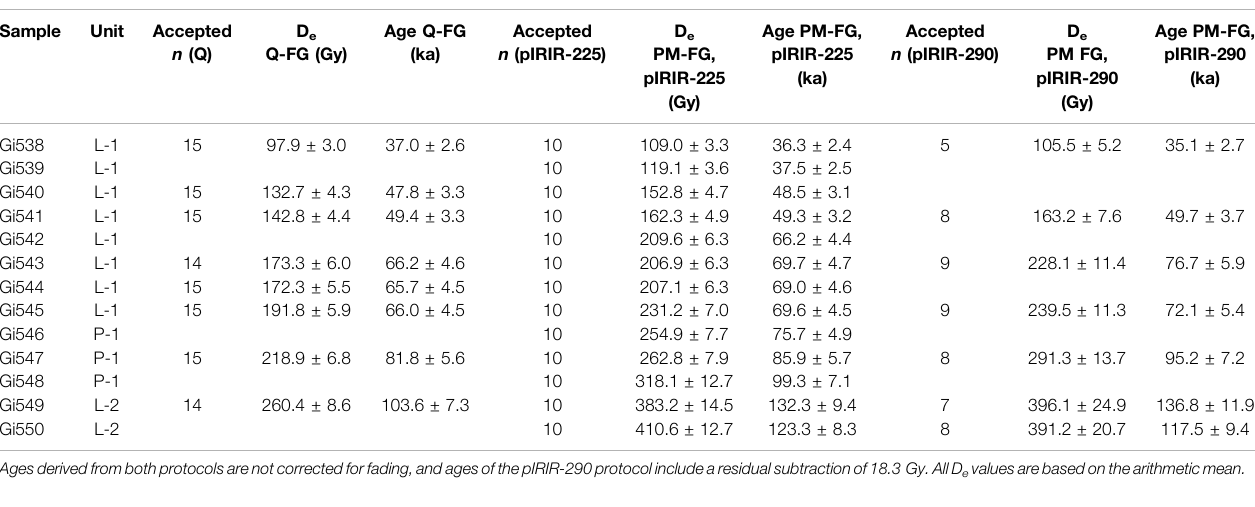
TABLE 6 | Luminescence ages for the quartz (Q-FG) and polymineral fi ne (PM-FG) grain fraction. Sample